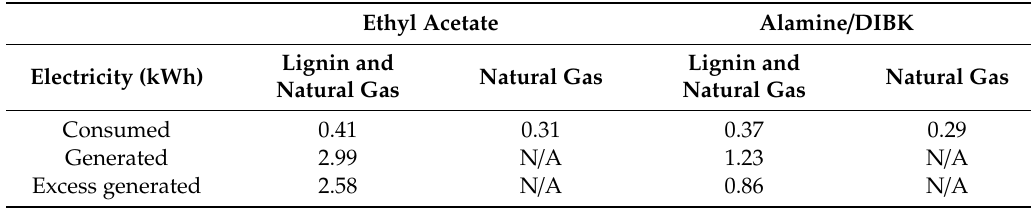
Table 4. Net biorefinery electricity per kg of acetic acid is